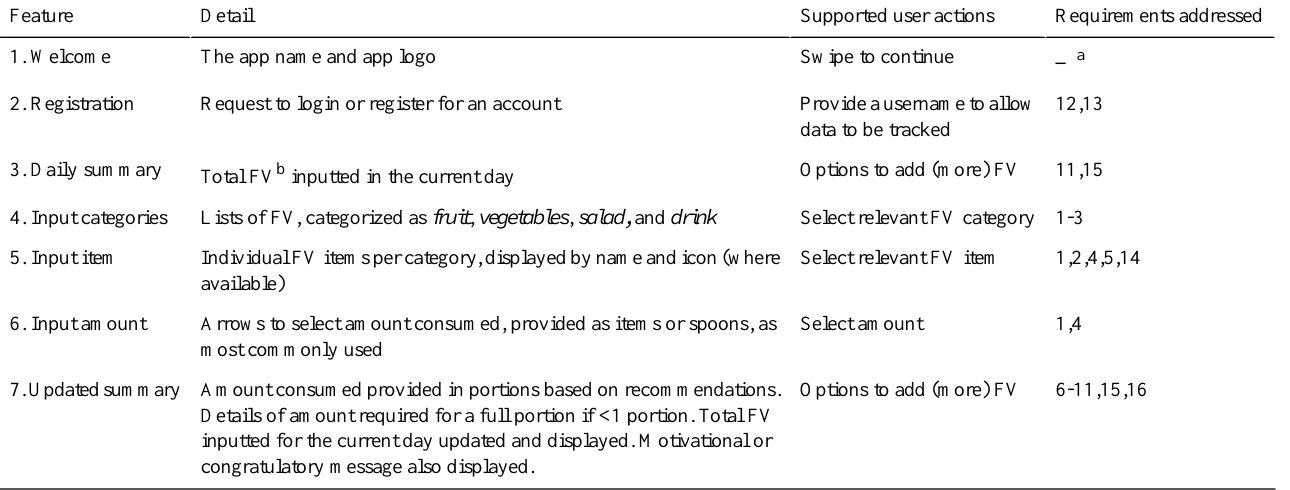
Table 2. Details of the prototype app.